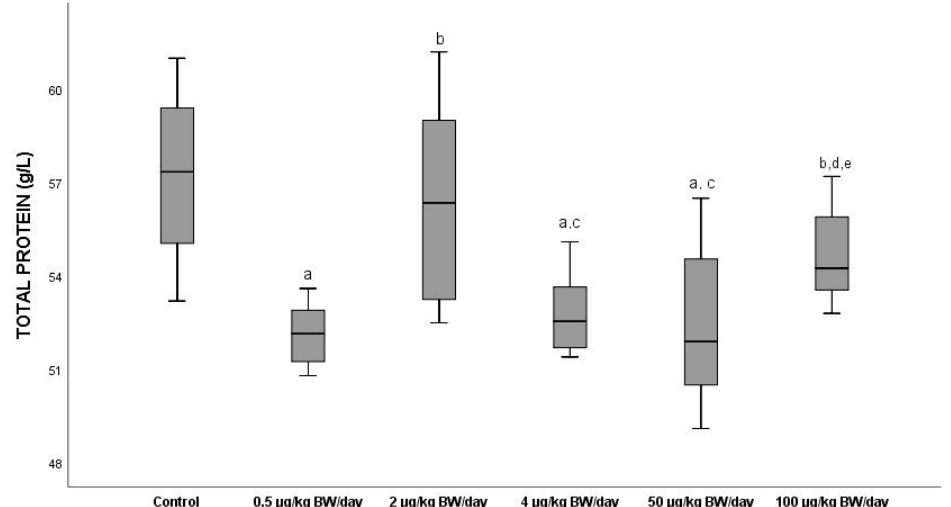
Figure 3. Means ± standard deviations of the serum levels of total proteins (TOT PROT) expressed in g/L in the different exposure groups. a significant differences vs. control (G0) ( p < 0.05); b significant differences vs. 0.5 µg/kg BW/day (G1); c significant differences vs. 2 µg/kg BW/day (G2); d significant differences vs. 4 µg/kg BW/day (G3); e significant differences vs. 50 µg/kg BW/day (G4).